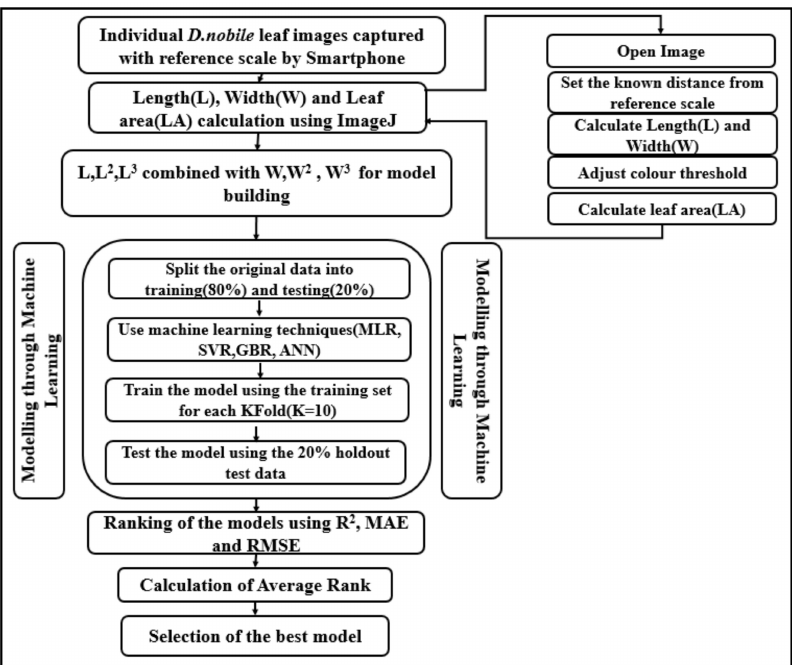
Figure 1. Flow diagram depicting the workflow of selection of best leaf area model through ML techniques in D. nobile